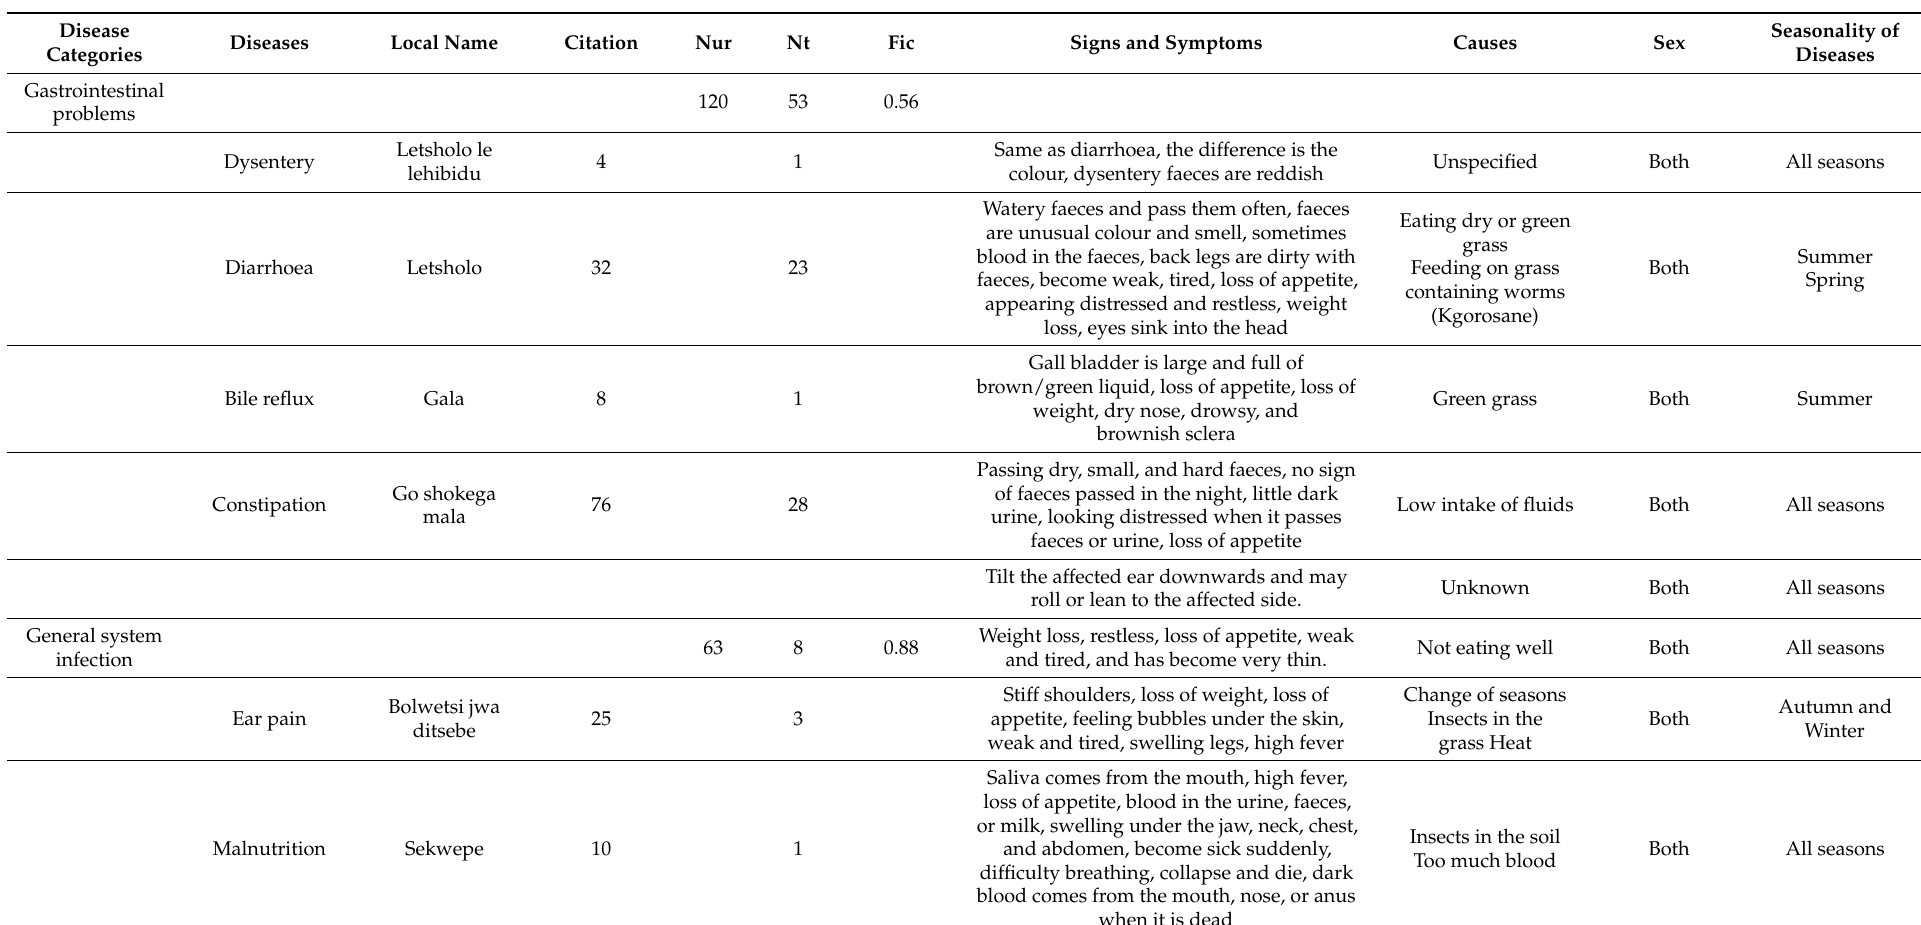
Table 2. Distribution of cattle diseases, causes, seasonality, sex, signs, and symptoms reported by participants in the study area. Nur denotes the number of usage reports for a certain disease category, whereas Nt denotes the variety of plants cited for the treatment of that specific ailment category, Fic = informant consensus